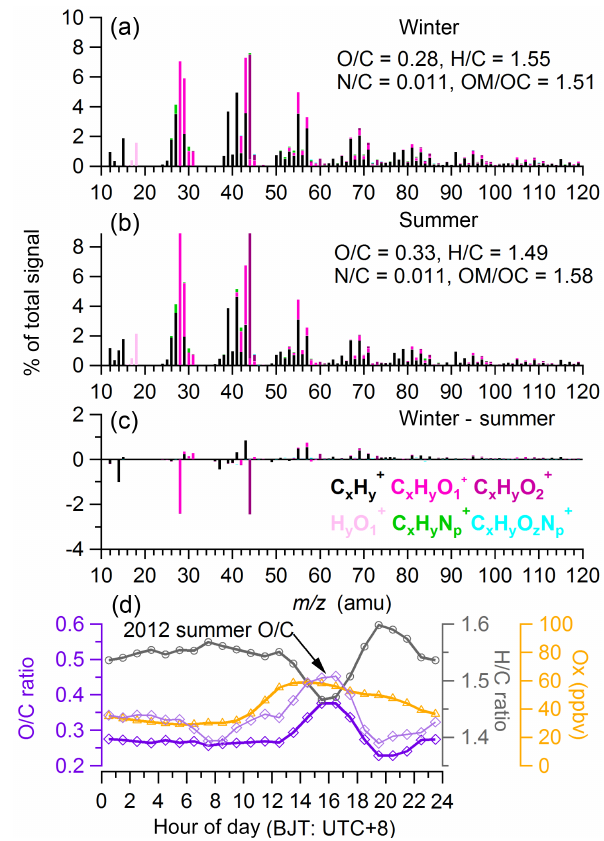
Figure 6. The average HR-MS and elemental ratios of organics for (a) this study, (b) summer 2012, (c) the HR-MS difference between this study and summer 2012, and (d) the diurnal variations of ele- mental ratios and odd oxygen (O x = NO 2 + O 3 )